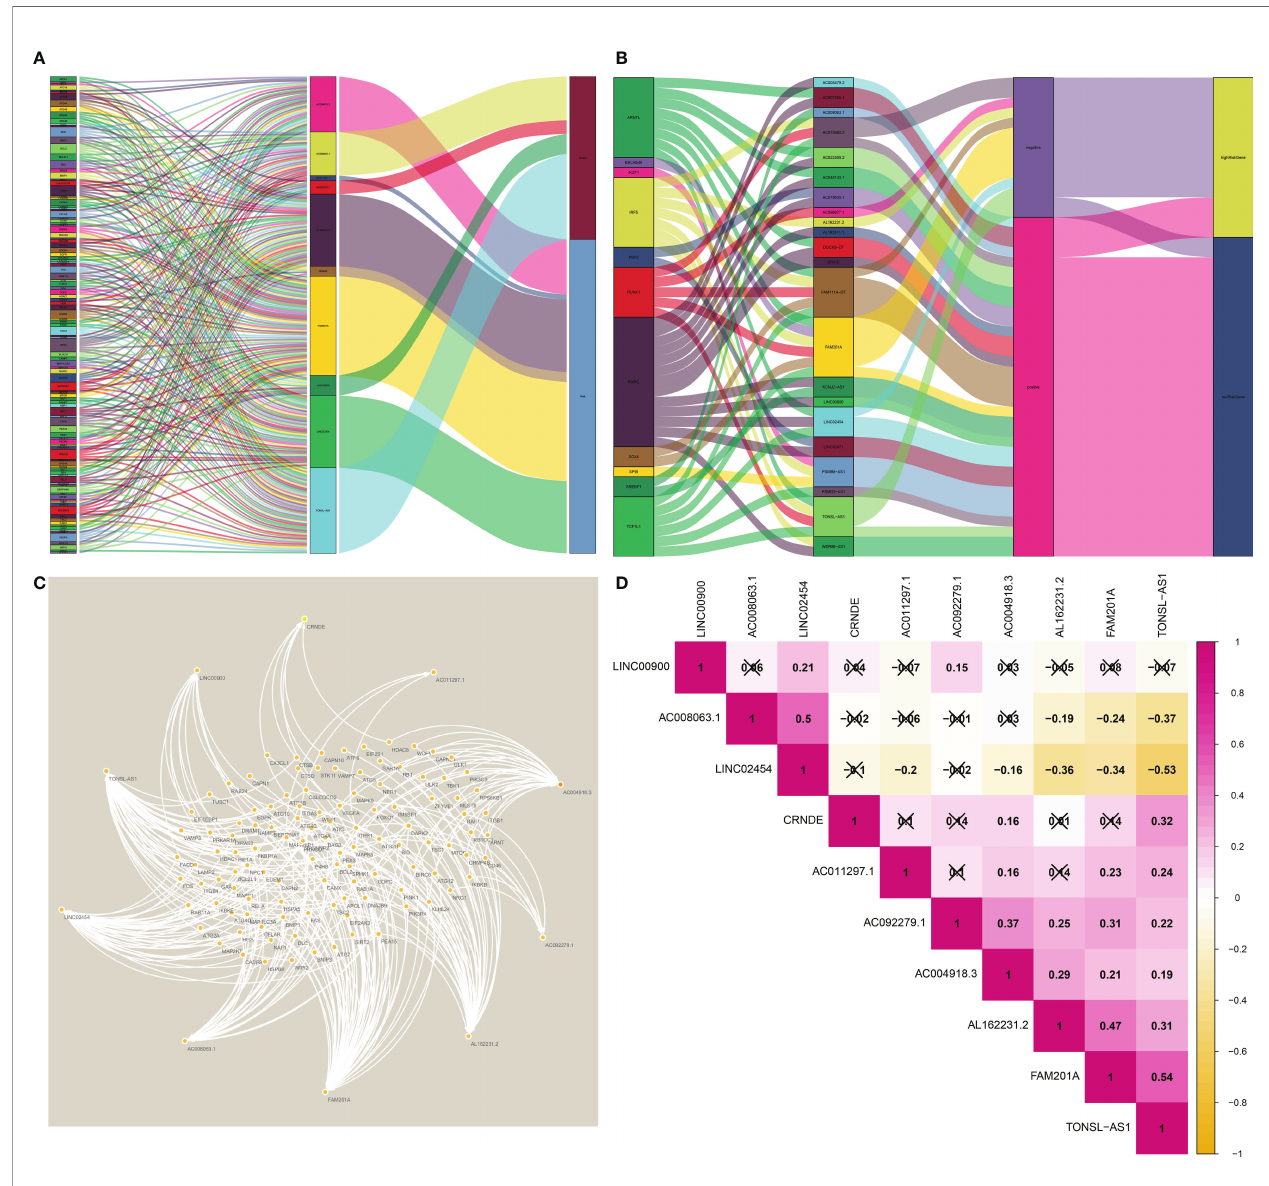
FIGURE 1 | Construction of the regulation network of the long noncoding RNAs (lncRNAs) with prognostic value and autophagy genes in papillary thyroid carcinoma (PTC). (A) The coexpression network of the 10 autophagy-related lncRNAs – messenger RNAs (mRNAs) with prognostic value was constructed and visualized using Sankey diagram between prognostic risk-related lncRNAs, mRNAs, and risk types (risk or protective). (B) The coexpression network of autophagy- related lncRNAs and matched transcriptional factors was constructed and visualized using Sankey diagram. (C) The network of autophagy gene and autophagy- related lncRNA. (D) The correlation of expression levels of lncRNAs involved in the risk strati fi